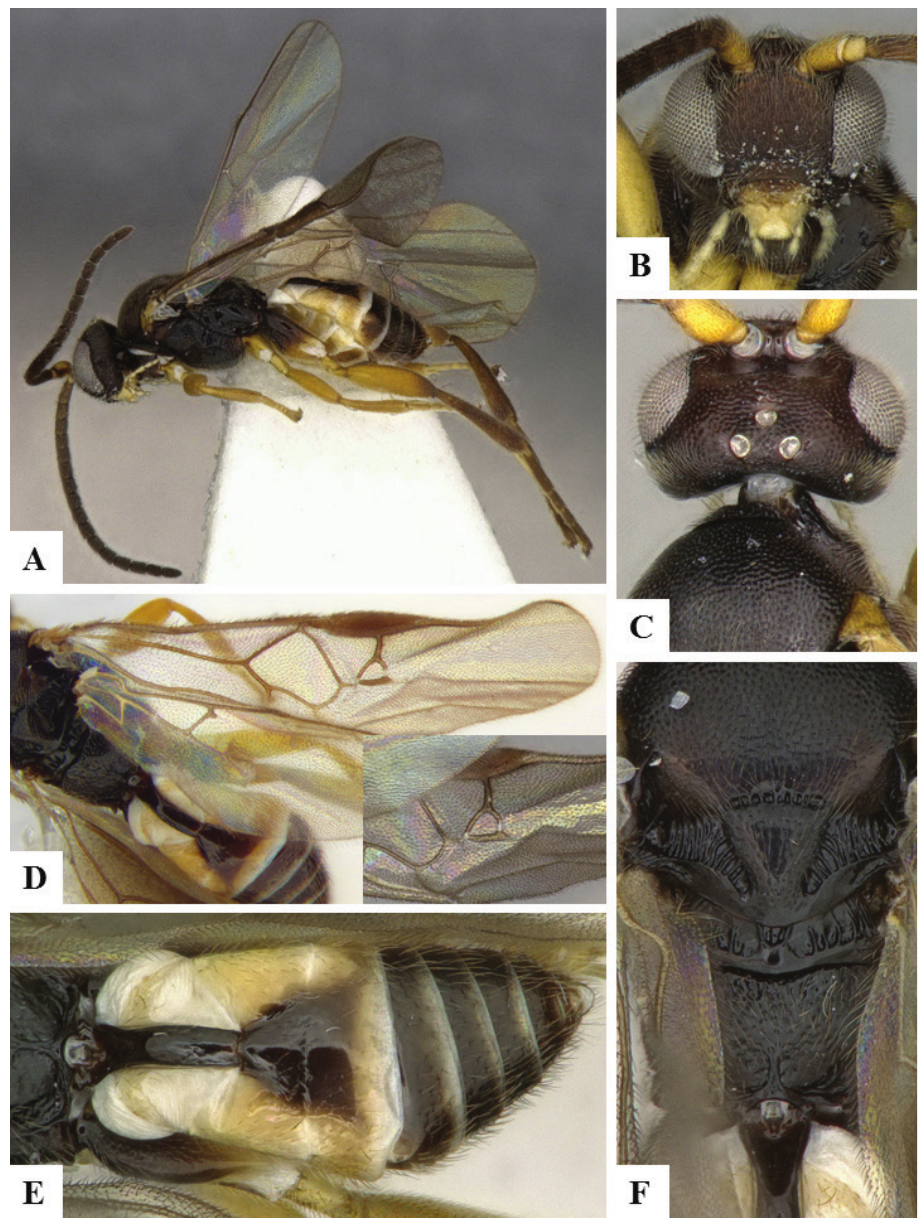
Figure 30. Markshawius francescae female paratype CNC878540. A Habitus B Head frontal C Head dorsal D Fore wing, inset: details of the areolet E Metasoma dorsal F Mesosoma dorsal. Voucher codes: CNCH1584, CNCH2146. Vietnam. (1 ♂ RMNH), Ninh Binh, Cuc Phuong National Park, near centre, 225m, 15–27.v.2000, coll. Mai Phu Quv, Vou- cher code: CNC878541; (1 ♂ RMNH), Hoa Binh, Pa Co Hang Kia Nature